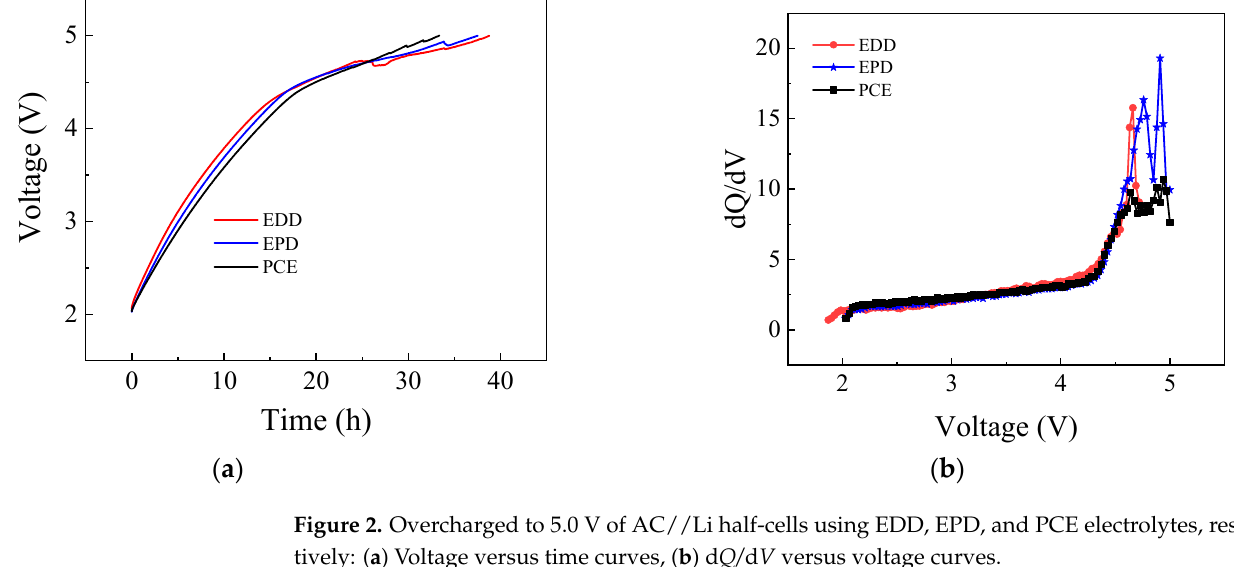
Figure 2. Overcharged to 5.0 V of AC//Li half-cells using EDD, EPD, and PCE electrolytes, respec- tively: ( a ) Voltage versus time curves, ( b ) d Q/ d V versus voltage curves.